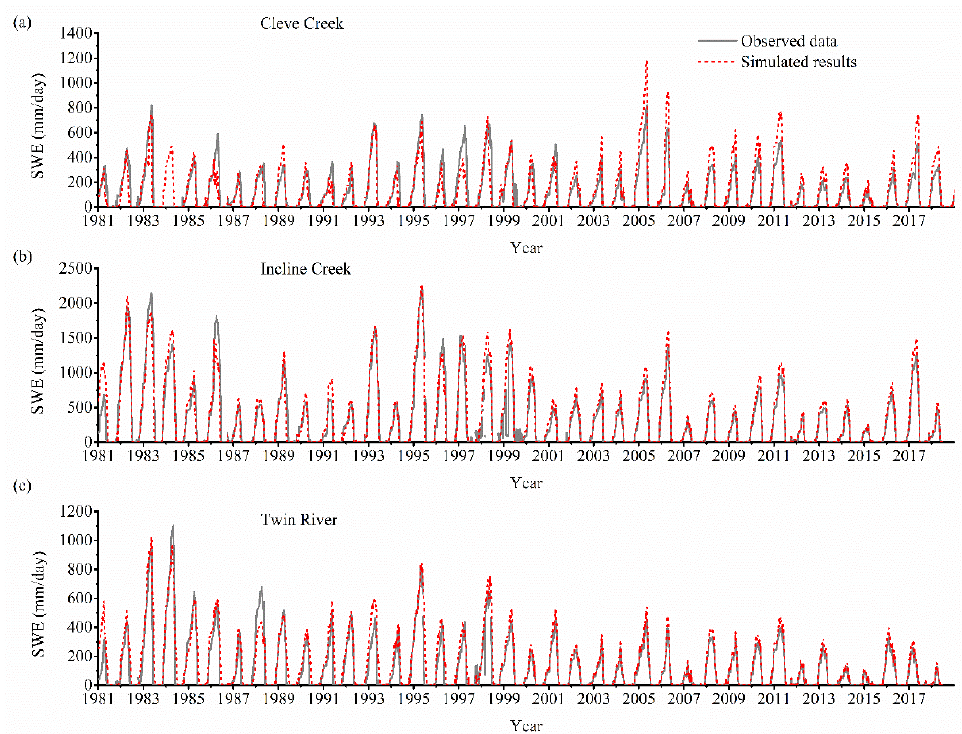
Figure 4. Comparison of observed and simulated daily mean snow water equivalent (SWE) from 1981 to 2017 for the three watersheds: ( a ) Cleve Creek, ( b ) Incline Creek, and ( c ) Twin River. Red lines denote the simulated results and grey lines represent the observed data.